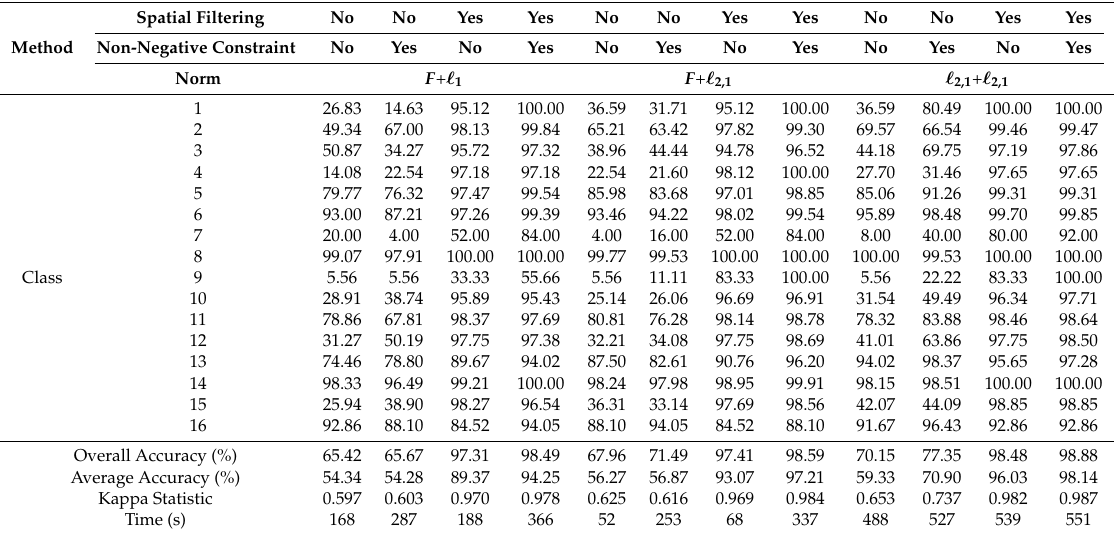
Table 4. Overall Accuracy, Average Accuracy, Kappa Statistic and Time of the Indian Pines data set when dealing with all the test pixels simultaneously.